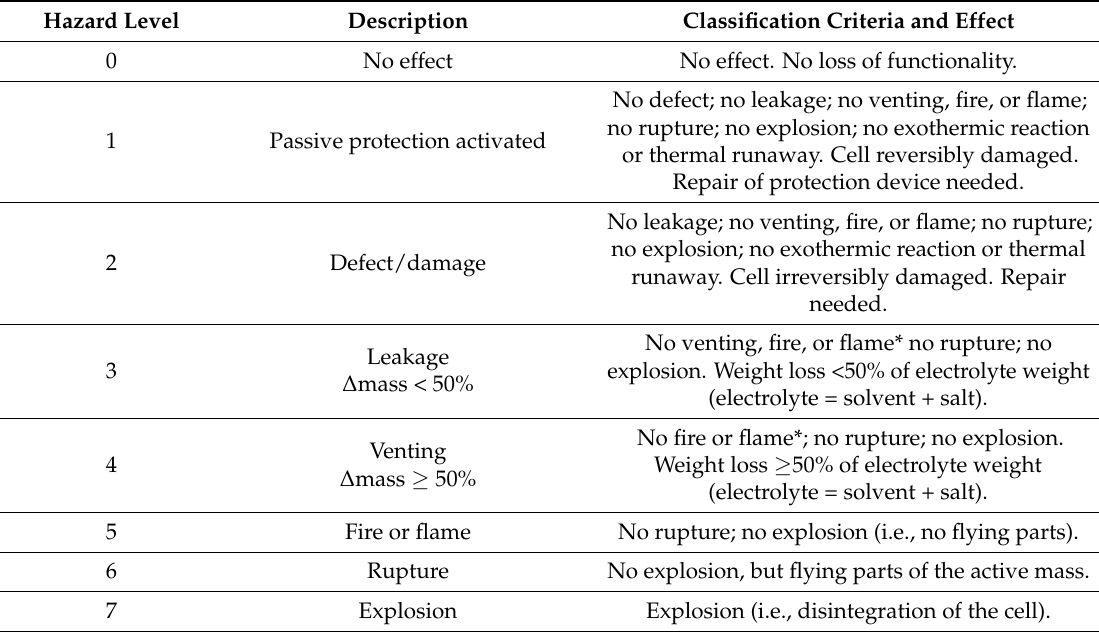
Table 2. European Council for Automotive Research and Development (EUCAR) hazard levels and descriptions